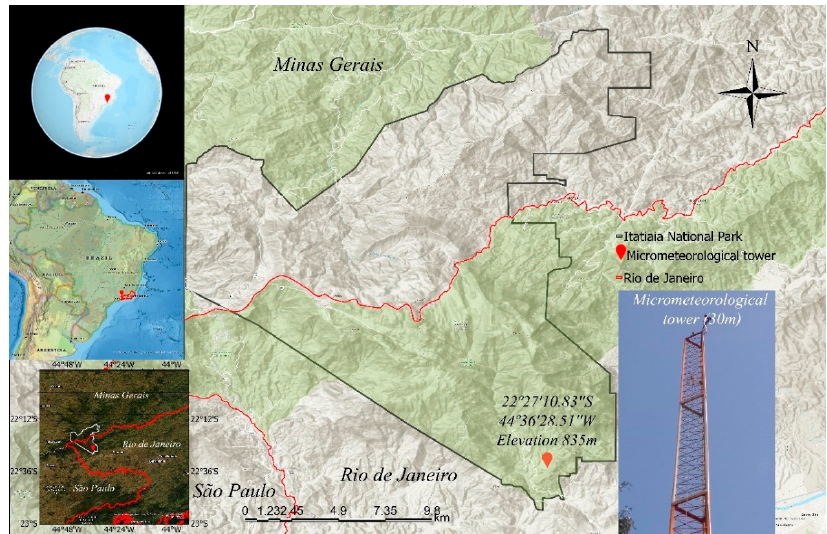
Figure 1. Geographic location of the study area. The micrometeorological tower used in this study is highlighted.